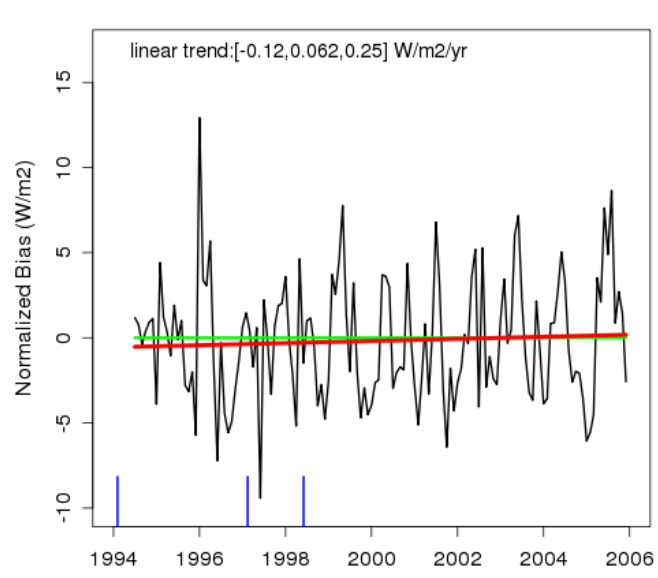
Figure 5. Temporal evolution of the normalized bias between the CM SAF data set and the BSRN data. Changes in the satellite instruments are indicated by the blue lines on the x-axis. The green line represents the zero line, the red line is the linear